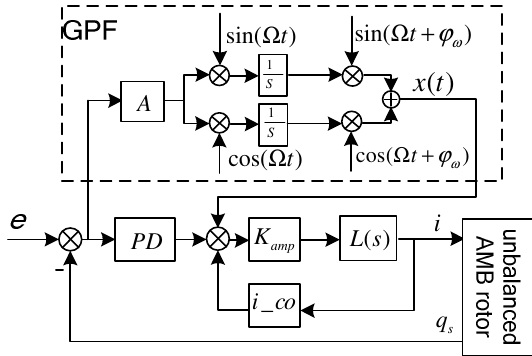
Figure 9. AMB control system including the GPF.